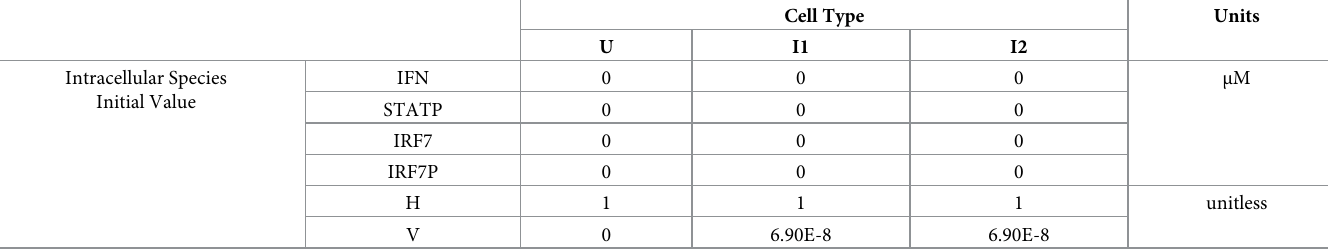
Table 1. Initial conditions for each cell type when present at the start of a simulated